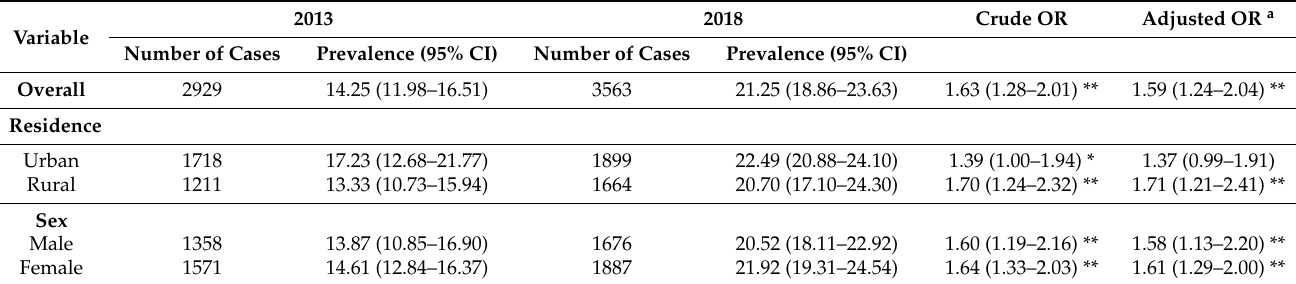
Table 2. Number of cases and 6-month prevalence rates of circulatory system diseases (CSDs) among inhabitants of Hunan Province, China, in 2013 and